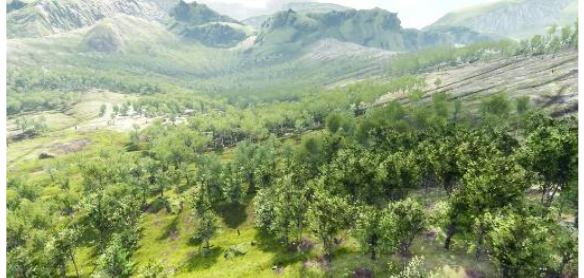
Figure 2. First virtual scene sample